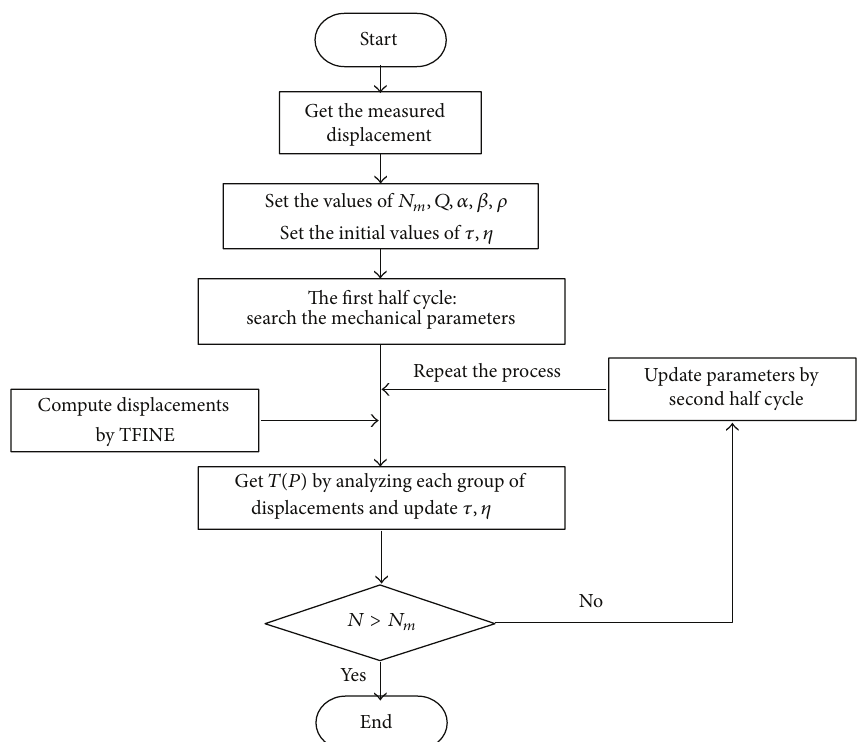
Figure 1: Flow chart of D-ACO inverse analysis for deformation of large arch